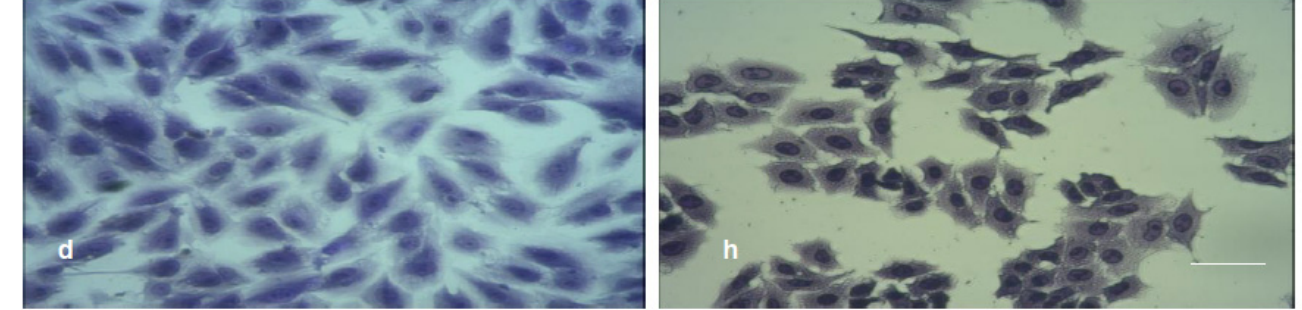
Figure 12. Cell morphology of MDCK II and A549 cell line on RGO and metal–RGO composites: ( a